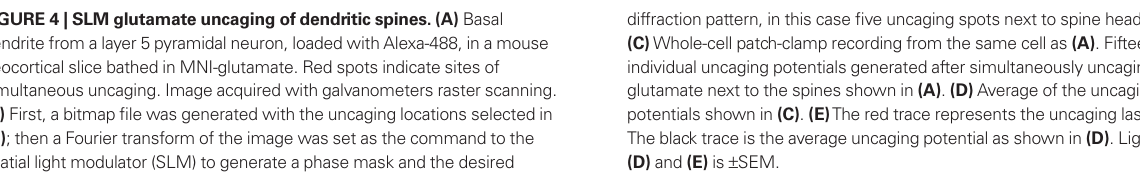
diffraction pattern, in this case fi ve uncaging spots next to spine heads (A) . (C) Whole-cell patch-clamp recording from the same cell as (A) . Fifteen individual uncaging potentials generated after simultaneously uncaging glutamate next to the spines shown in (A) . (D) Average of the uncaging potentials shown in (C) . (E) The red trace represents the uncaging laser pulse. The black trace is the average uncaging potential as shown in (D) . Light gray in (D) and (E) is ±